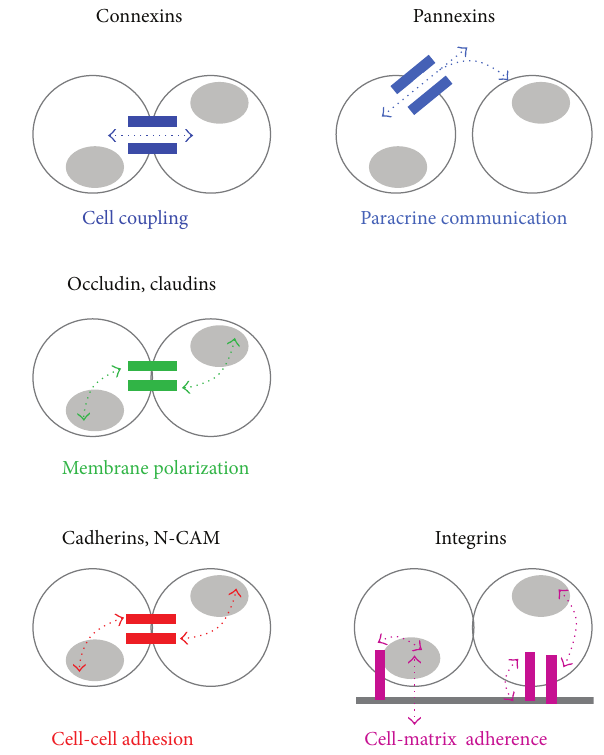
F 2: Different membrane proteins account for different modalities of -cell communication. Connexins mediate the direct cell-to-cell transfer of cytosolic molecules (dotted, double arrow head) between adjacent cells, an event referred to as cell-to-cell 𝛽𝛽 coupling. Pannexins mediate the exchange of molecules (dotted) between the cytosol and the extracellular space of cells. Some of the cytosolic molecules which exit cells through pannexin channels could ensure paracrine communication between close-by cells. Occludin and claudins provide for the sealing of small domains of the cell membrane and of portions of the islet extracellular spaces, hence establishing the polarity of -cells. Cadherins and N-CAM ensure the adhesion between islet cells in contact. Integrins mediate the adherence of islet cells to the extracellular basal lamina (grey 𝛽𝛽 band) and matrix. Claudins, cadherins, N-CAM, and integrins also provideforthein-outandout-insignalingof -cells(curved,double arrow heads) notably with regard to gene 𝛽𝛽